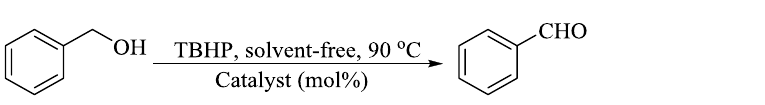
Figure 13. Role of the catalyst in the oxidation of benzyl alcohol.